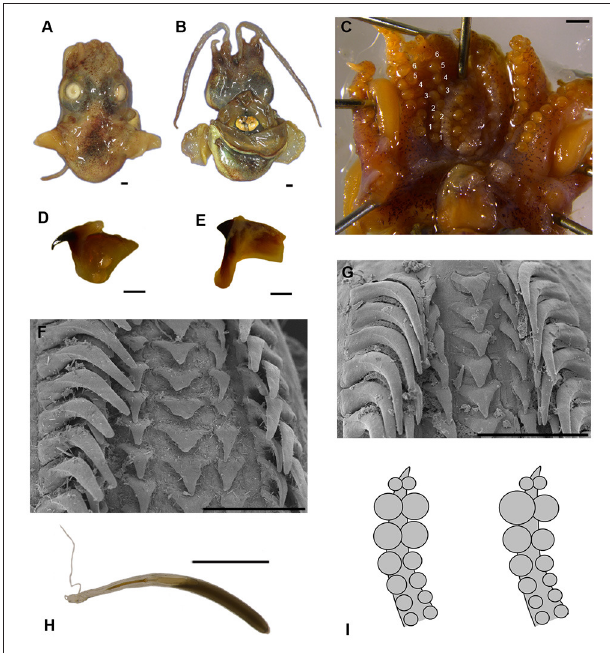
FIGURE 4 | Stoloteuthis cthulhui sp. nov . (A) Dorsal view of the mature female specimen 12.3mm ML ICMC000163. (B) Ventral view of the mature male specimen 13.9mm ML ICMC000164 (holotype). (C) Dissected arm crown showing the arrangement of the suckers of the arms of the mature male 17.9mm ML ICMC000165. Numbers above the suckers of the right arm II depict the rows of suckers. (D) Lower beak of the mature specimen 16.7mm ML ICMC000166. (E) Upper beak of the specimen ICMC000163. (F) Radula of the specimen ICMC000165. (G) Radula of the Stoloteuthis leucoptera specimen ICMC000175, mature female 13.3mm ML. (H) Spermatophore of the specimen ICMC000166. (I) Arrangement and relative size of arm II